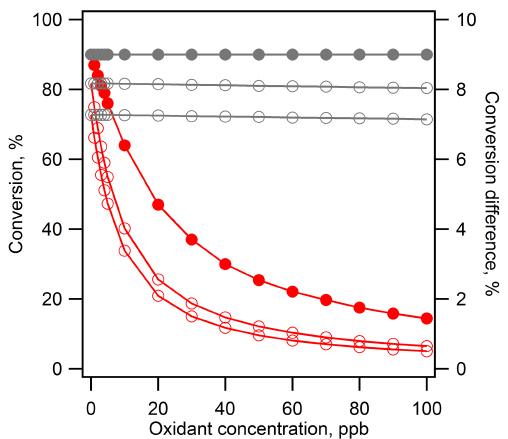
Figure 5. Simulated conversion (open circles) and difference in conversion (closed circles) for photolytic converters with different j in the presence of OH (red) and O 3 (grey)